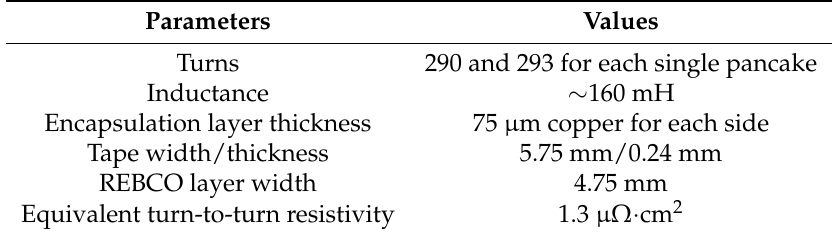
Figure 10. DP Module: ( a ) non-insulation winding; ( b ) front view; ( c ) oblique view; ( d ) lateral view. Table 3. Parameters of the DP